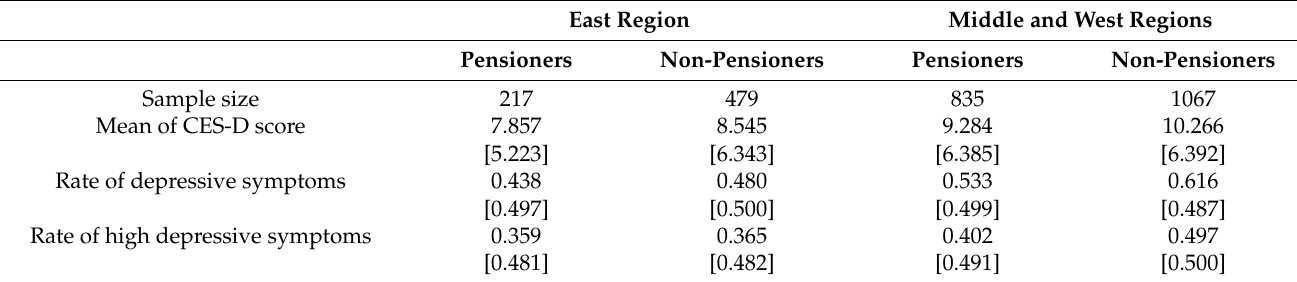
Table 2. NRSPI pension receipt, CES-D score and depressive symptoms by region. East